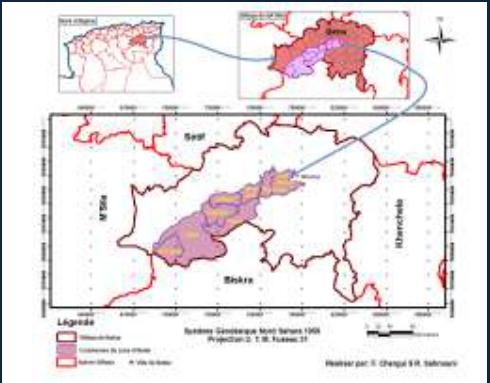
Figure1 . Location map of the study